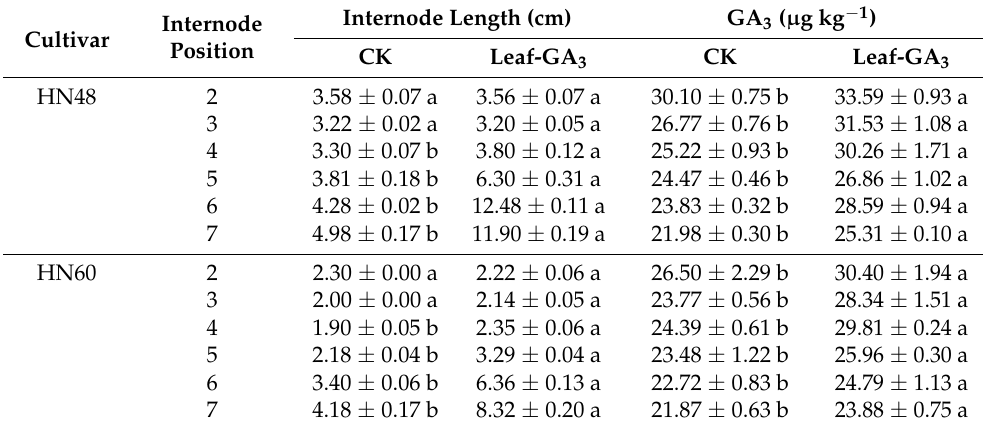
Table 2. Effects of GA 3 application to soybean leaves on internode elongation and stem GA 3 content.